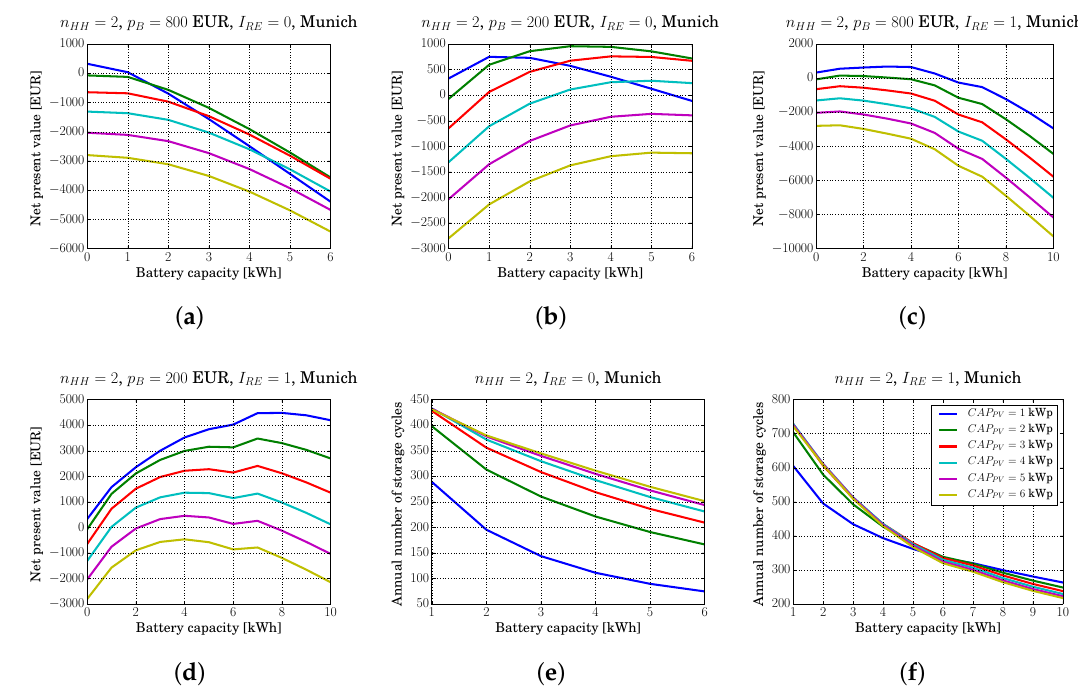
Figure 5. NPVs ( a – d ) and annual number of battery cycles ( e , f ) for different solar PV and battery capacities. Figure 6e,f show self-sufficiency rates for the cases without and with reserve provision (solid and dashed lines, respectively). Whereas the use of additional energy storage capacity at